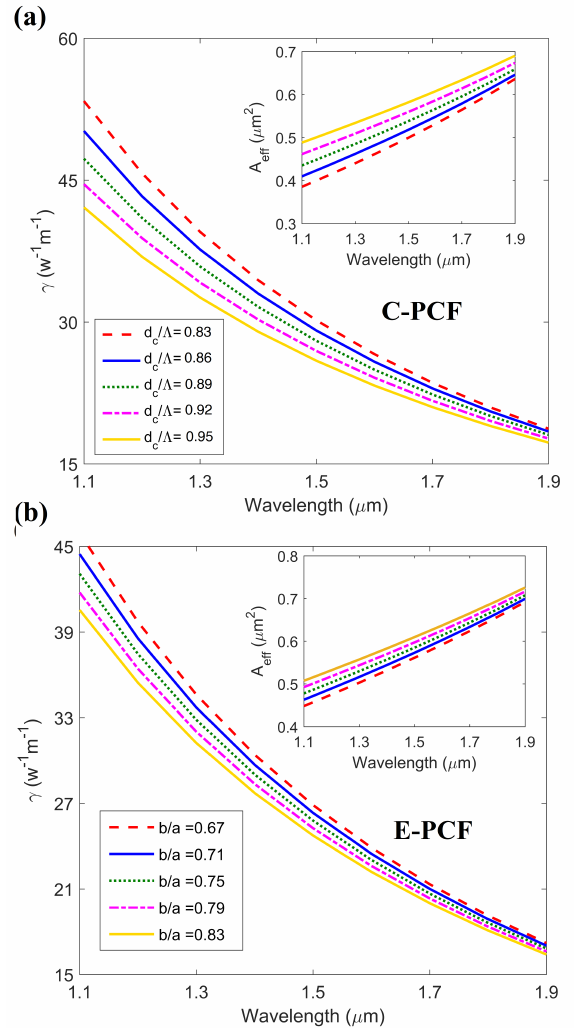
Figure 8. Non-linear coefficient (main plots) and effective mode area (inset plots) of PCFs with ( a ) circular-core, and ( b ) elliptical-core, with different core dimensions as a function of excitation wavelengths. The C-PCF and E-PCF parameters are: d = 0.692, Λ = 0.867, a = 1 µ